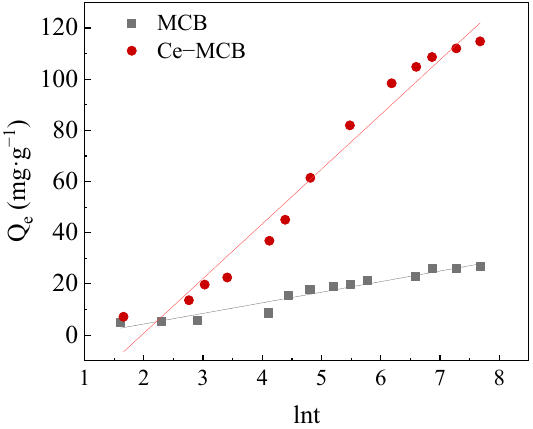
t 1/2 Figure 12. Intra-particle diffusion model of biochar to Pb 2+.